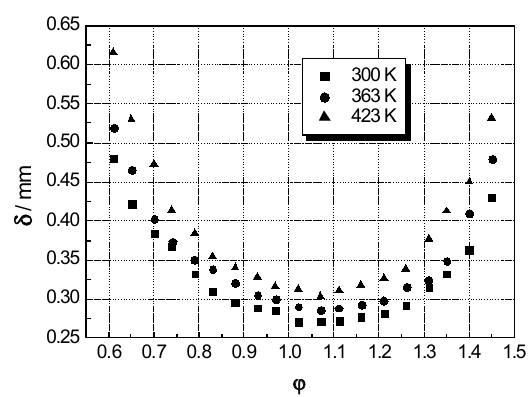
Figure 7. Temperature profiles of lean C